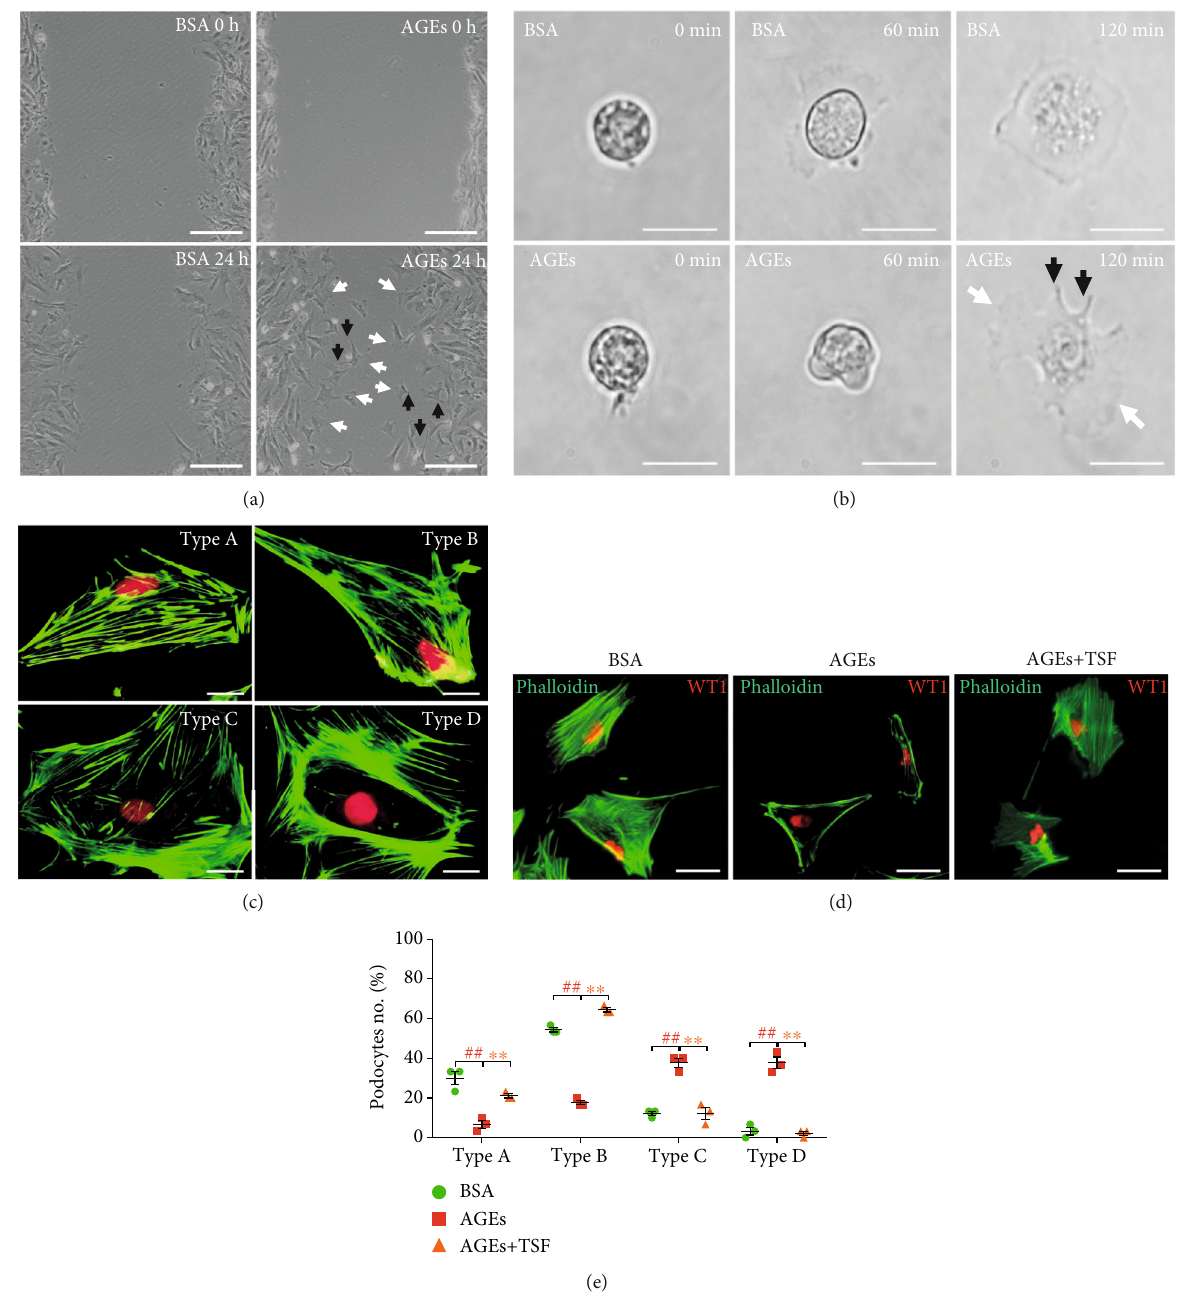
Figure 5: TSF inhibited actin-cytoskeletal disorganization in AGEs-stimulated primary mice podocytes. (a) Morphology of primary mice podocytes in wound healing assay (scale bars, 100 μ m). (b) Time-lapse images of primary mice podocytes (scale bars, 50 μ m). Lamellipodia are marked with white arrows and fi lopodia with black arrows. (c) Representative images of di ff erent types of phalloidin staining patterns observed in isolated control podocytes (scale bars, 25 μ m). (d) Representative immuno fl uorescence stained with phalloidin and WT1 showed actin-cytoskeletal disorganization in AGEs-stimulated primary mice podocytes which could be relieved by TSF (scale bars, 50 μ m). (e) Quantitative analysis of the percentage of four types of phalloidin staining patterns in (d) by a blinded observer (30 cells evaluated per experiment, n = 3 experiments). The data were expressed as the mean ± SEM of three independent experiments performed in triplicate. # P < 0 : 05 , ## P < 0 : 01 vs. BSA group; ∗ P < 0 : 05 , ∗∗ P < 0 : 01 vs. AGEs group. Statistically analyzed via a one-way ANOVA with Dunnett ’ s